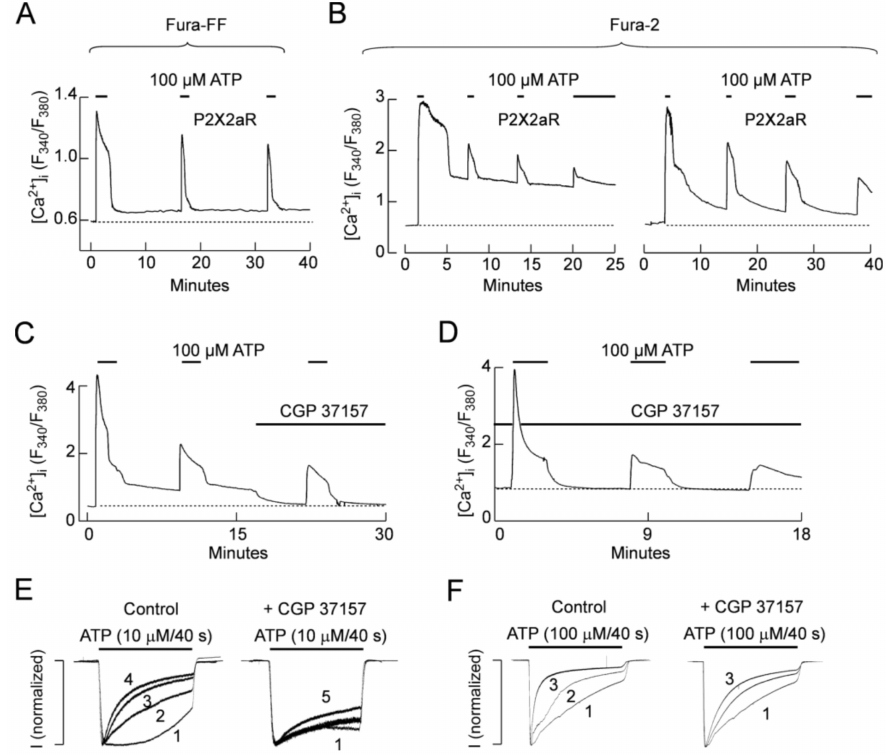
Figure 10. Repetitive ATP application increases basal [Ca 2+ ] i . ( A , B ) Representative [Ca 2+ ] i recordings from a P2X2aR-expressing GT1-7 cell in which 3 consecutive ATP application were done (horizontal black bars) with washout period of 15 min between pulses. Recordings were done using Fura-FF ( A ) or Fura-2 ( B ) as Ca 2+ -indicator; ( C , D ) Representative [Ca 2+ ] i recordings from a P2X2aR-expressing GT1-7 cells in which 4 µ M CGP 37157 was applied in the middle ( C ) or during the whole experiment ( D ). Horizontal black bars represent 100 µ M ATP applications and dotted lines indicate the basal [Ca 2+ ] i before to the first ATP application; ( E , F ) Representative recordings from P2X2aR-HEK293 cells in the absence (left) and in the presence (right) of 10 µ M CGP 37157; currents were gated with 10 µ M ( E ) or 100 µ M ( F )